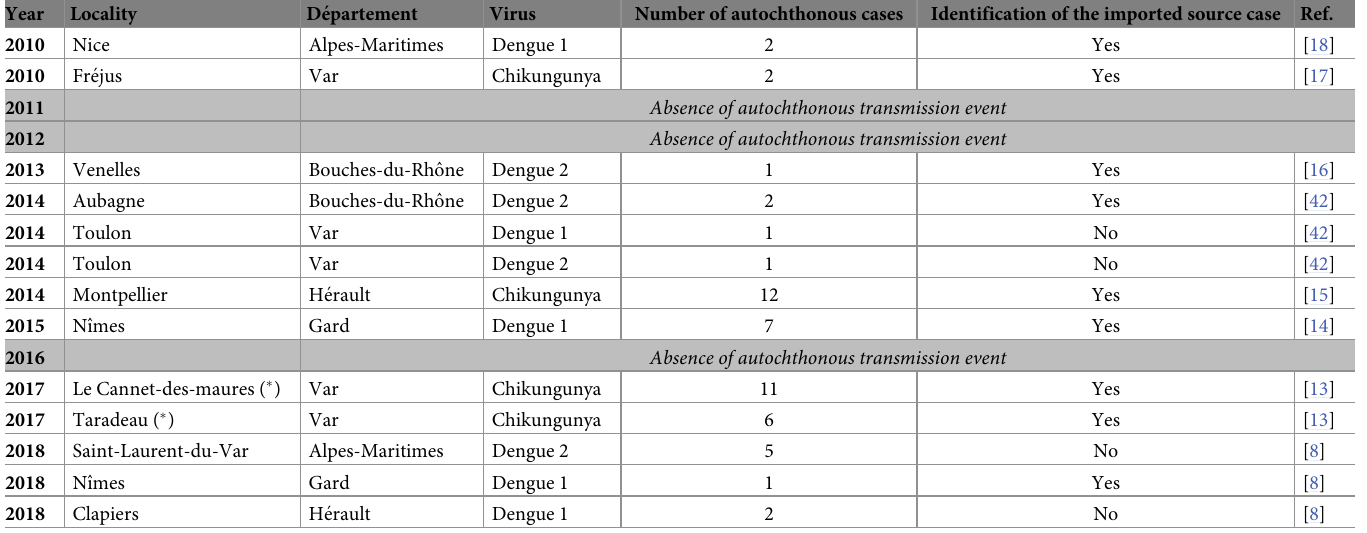
Table 2. Dengue and chikungunya autochthonous transmission events in France between 2010 and 2018.